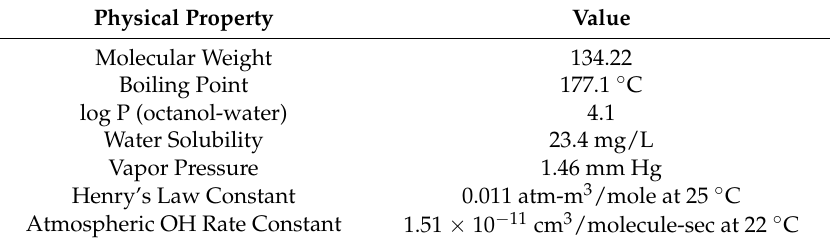
Table 1. Some physical properties of p-cymene [17].